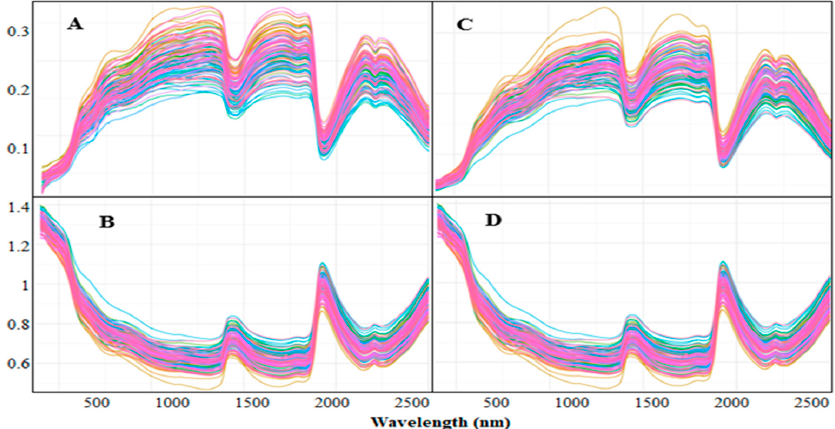
Figure 3. Spectra transforms showing field (left: A,B ) and lab-wet (right: C,D ) reflectance (top: A,C ) and absorbance (bottom: B,D ) features.